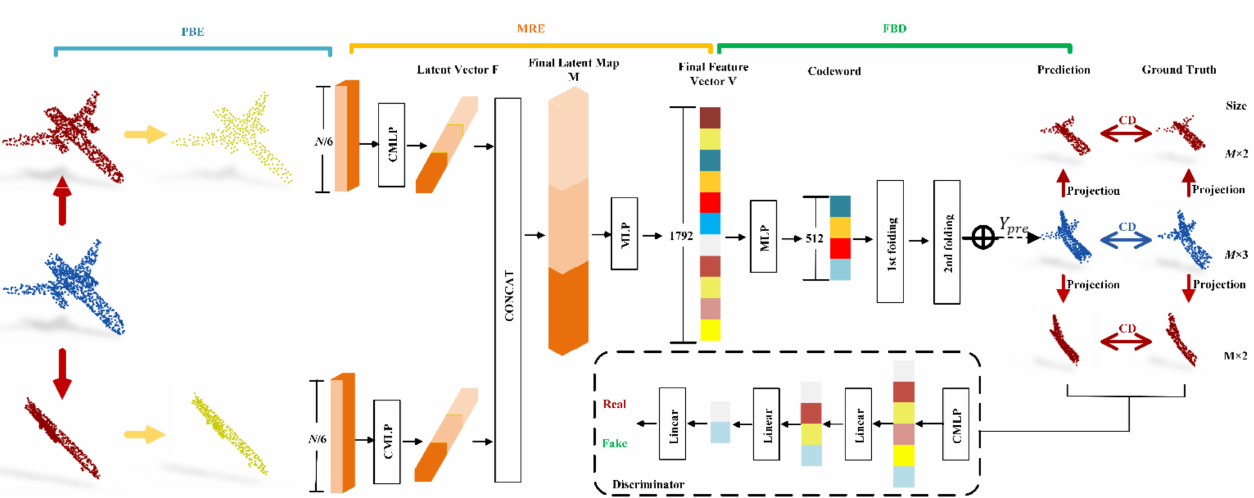
Figure 2. PP-Net architecture. In the PBE module (Section 2.3), the point cloud is projected to different directions (indicated in red). The boundary extraction method is used to extract the projected boundary feature points (indicated in yellow). After generating the predicted point cloud (indicated in blue), the point cloud is projected in multiple different directions (indicated in red). Then, the CD errors of both the point cloud and projection are calculated (Section 2.6).